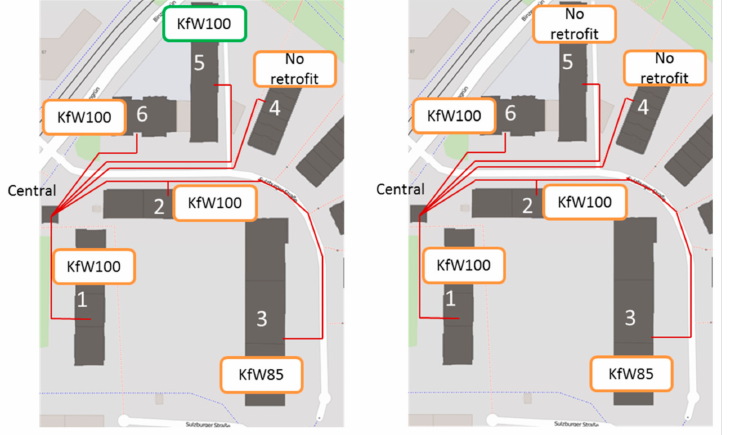
Figure 10. Left picture displays retrofit decisions of the perfect foresight and the right picture of the myopic approach.